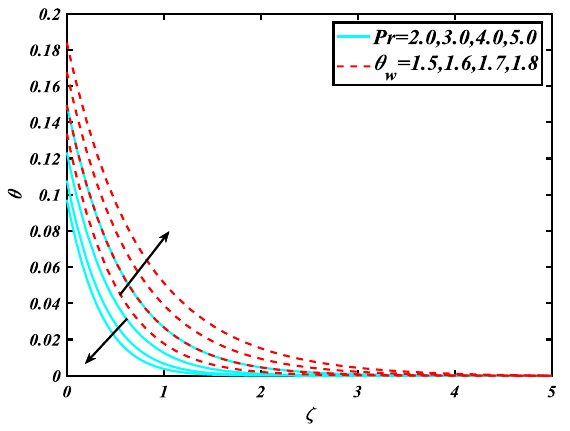
Figure 5. Significance of Pr & θ w for θ .